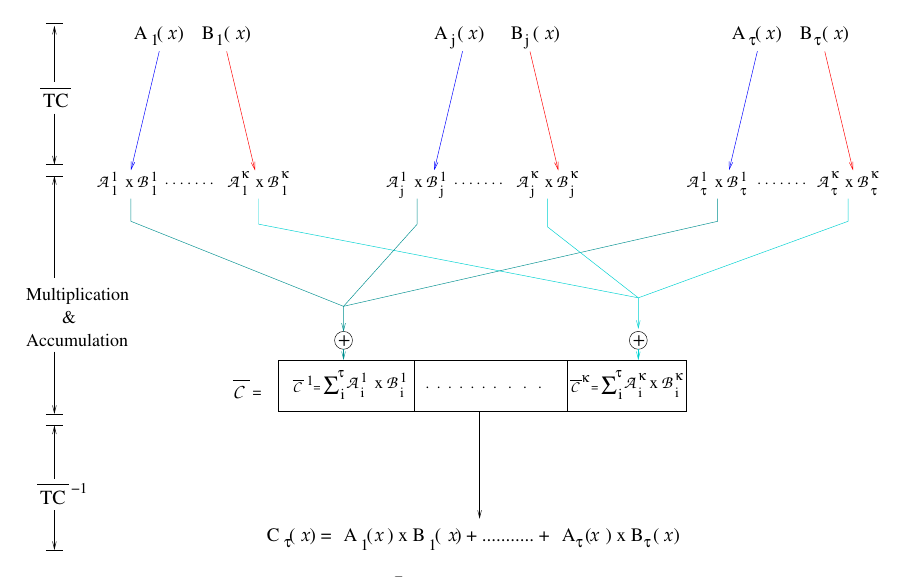
Figure 3: Calculating C τ = P τ